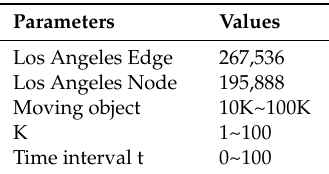
Table 1. Comparative test data.